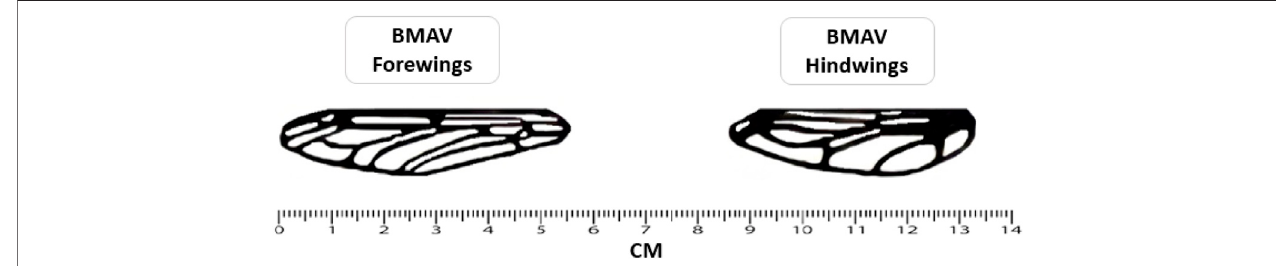
FIGURE 1 | Fabricated wings utilized in the present study.